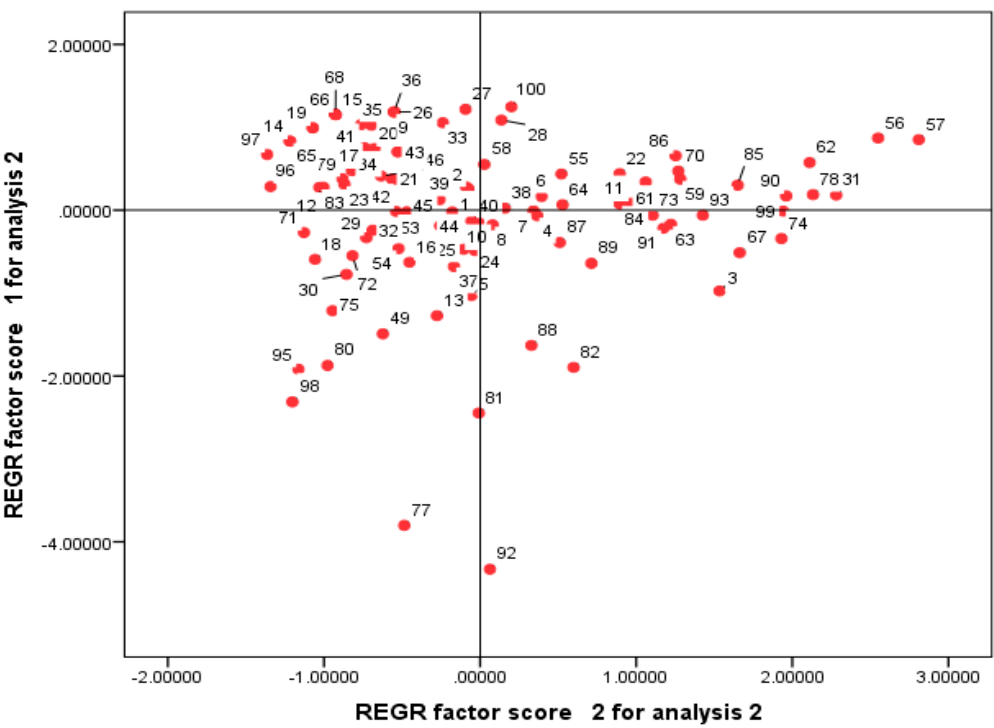
Figure 6. Scatter plot of regression factor score of households in Kofa from the two PCA factors.